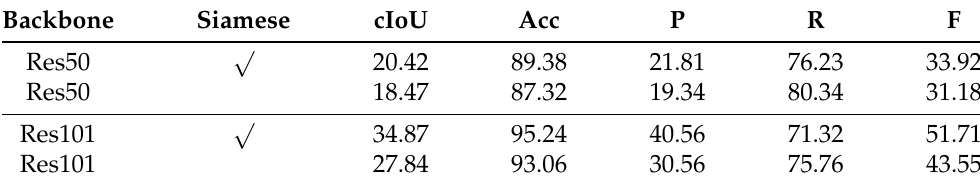
Table 5. Ablation study for siamese architecture. features to generate the final Predictions.